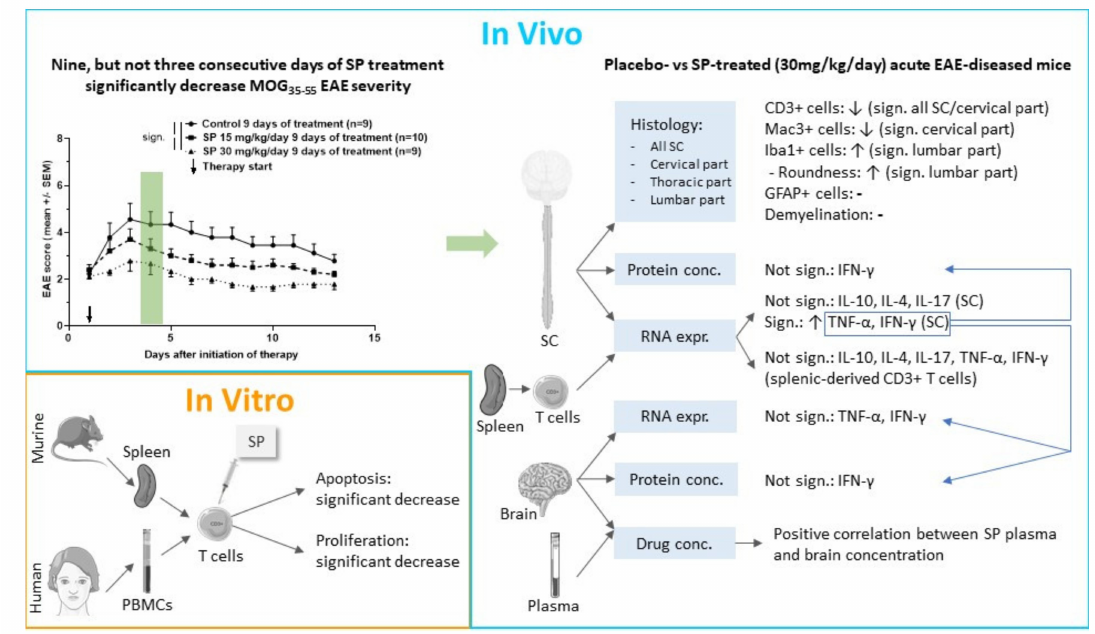
Figure 6. Graphical abstract summarizing key experiments and results of this study. Abbreviations: conc.: Concentration, EAE: Experimental autoimmune encephalomyelitis, expr.: Expression, sign.: Significant, SC: Spinal cord, SP: SP600125 and PBMCs: Peripheral blood mononuclear cells.